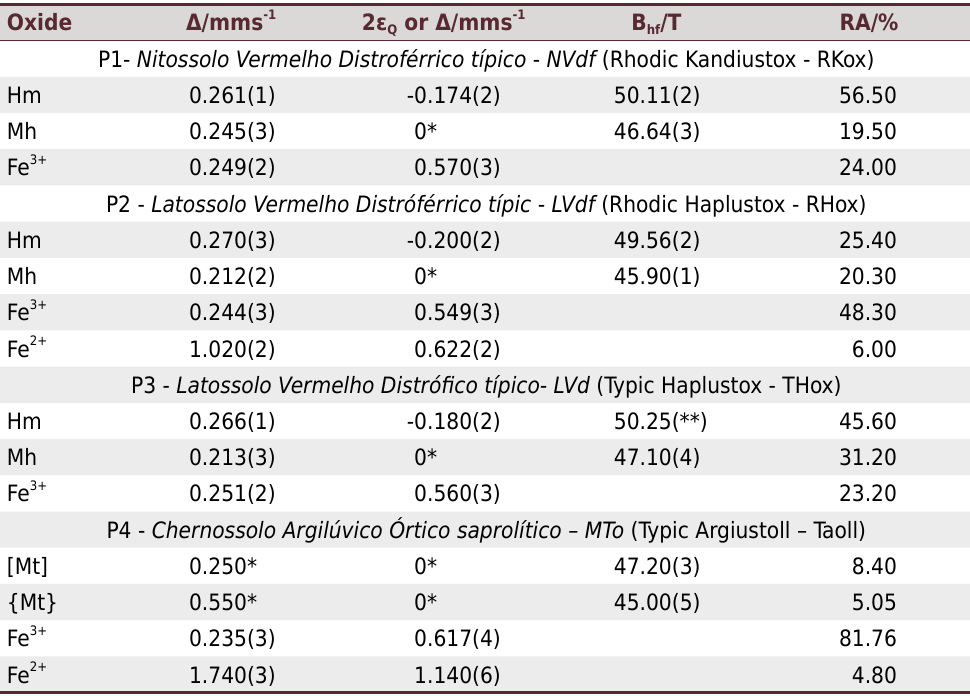
Table 5. 57 Fe hyperfine spectral parameters at room temperature (~298 K) for samples from soils of the Southern Espinhaço Mountain Chain and Upper Jequitinhonha Valley Oxide